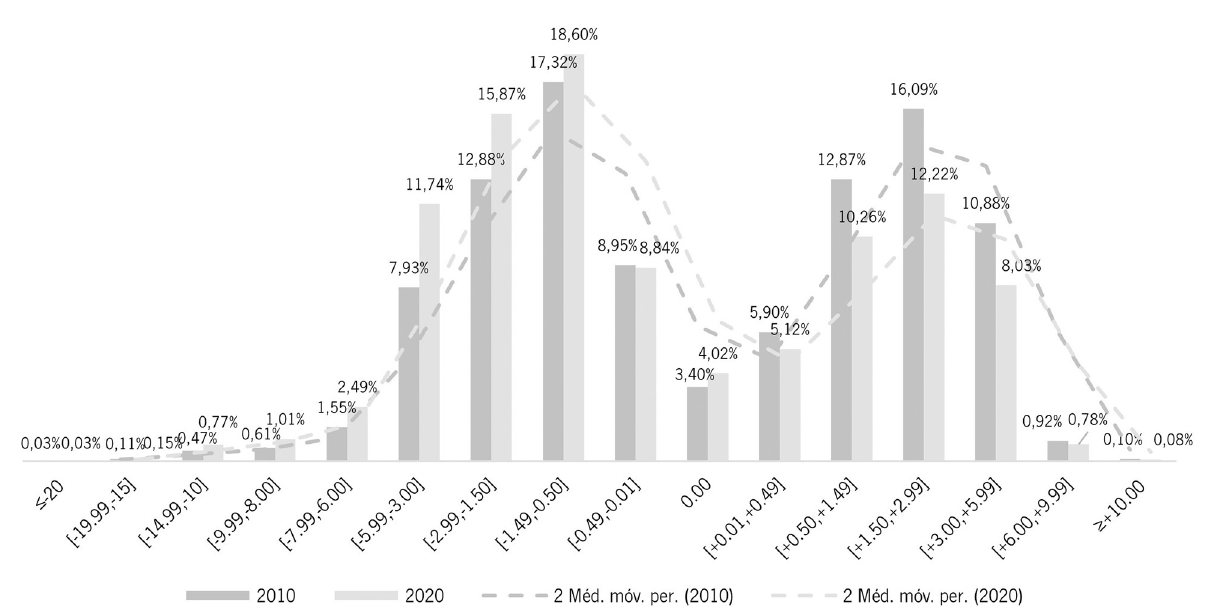
Fig 6. Trends in the distribution of ophthalmic prescriptions in Portugal for the years of 2010 and 2020 for each spherical equivalent range according to single vision ophthalmic lenses prescriptions. Dashed lines show average fitting and 2010–2020 shift in prescription delivery